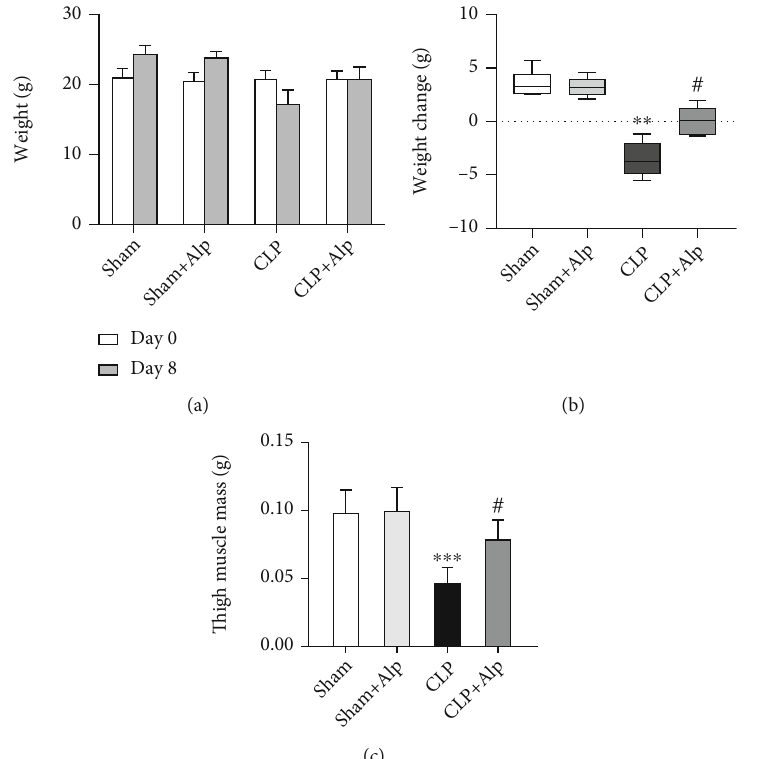
Figure 4: E ff ects of alpinetin on weight changes after the procedure. (a) Mice were weighed before the operation (day 0) and on the eighth day after the procedure (day 8). Groups were then compared in terms of (b) absolute change in weight and (c) thigh muscle weight. Sham ( n = 10 ), sham+Alp ( n = 10 ), CLP ( n = 6 ), and CLP+Alp ( n = 8 ). Data are shown as mean ± SD . ∗∗ p < 0 : 01 , ∗∗∗ p < 0 : 001 , CLP vs. sham; # p < 0 : 05 , CLP- Alp vs. CLP.